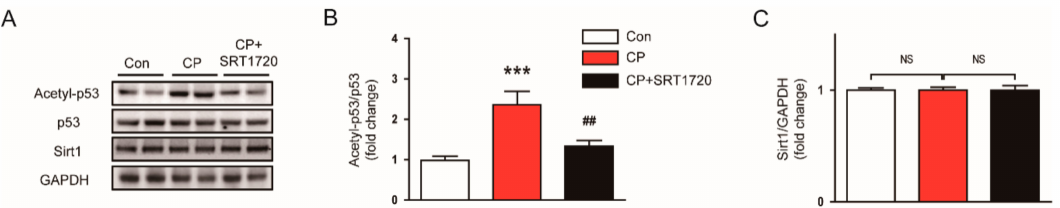
Figure 5. E ff ects of SRT1720 on Sirtuin 1 (Sirt1) expression and p53 acetylation in kidneys of cisplatin-treatedmice. ( A )Westernblotsofacetyl-p53, p53, andSrit1levelsinkidneys. ( B )Quantification of acetyl-p53 level. ( C ) Quantification of Sirt1 level. *** p < 0.001 vs. Con. ## p < 0.01 vs. CP. NS, not